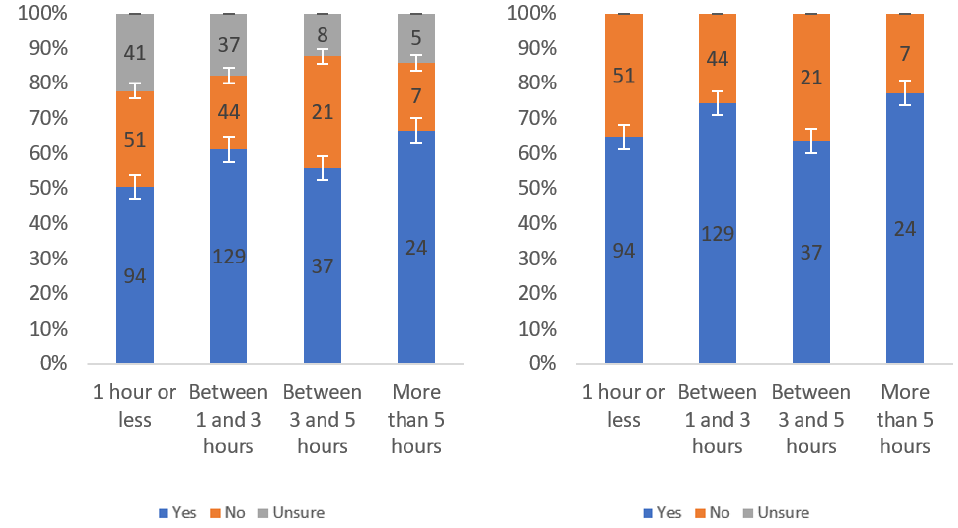
Figure 37. Responses regarding usefulness in judging trustworthiness by internet usage level including ( left ) and excluding ( right ) unsure responses.